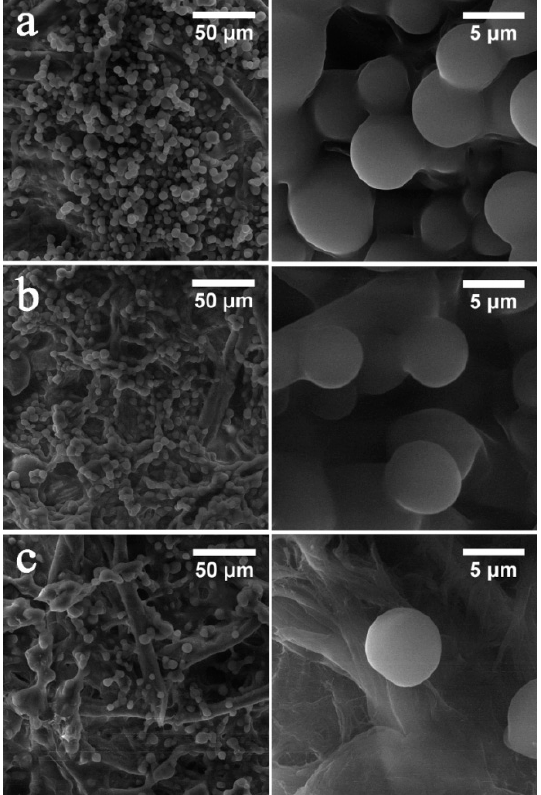
Figure 1. Morphology of pure biopolymer and polyene-containing biopolymer microspheres: ( a ) PHA; ( b ) PHA-20-Nys and ( c ) PHA-20-AmB at lower magnification (scale bar of 50 µM) and higher magnification (scale bar of 5 µM) are shown. Background structures are cellulose filaments of the paper on which samples were deposited.